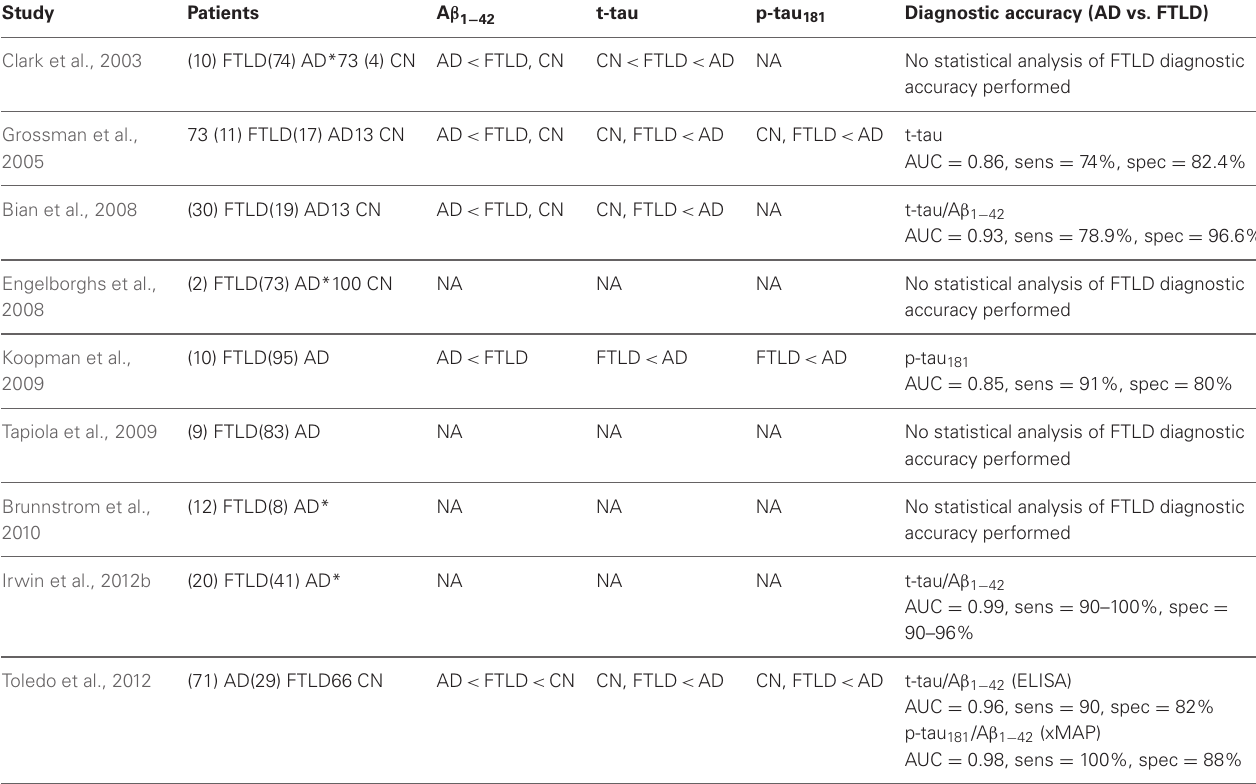
Table 1 | Comparative studies of CSF biomarkers in autopsy/genetic-confirmed FTLD and AD